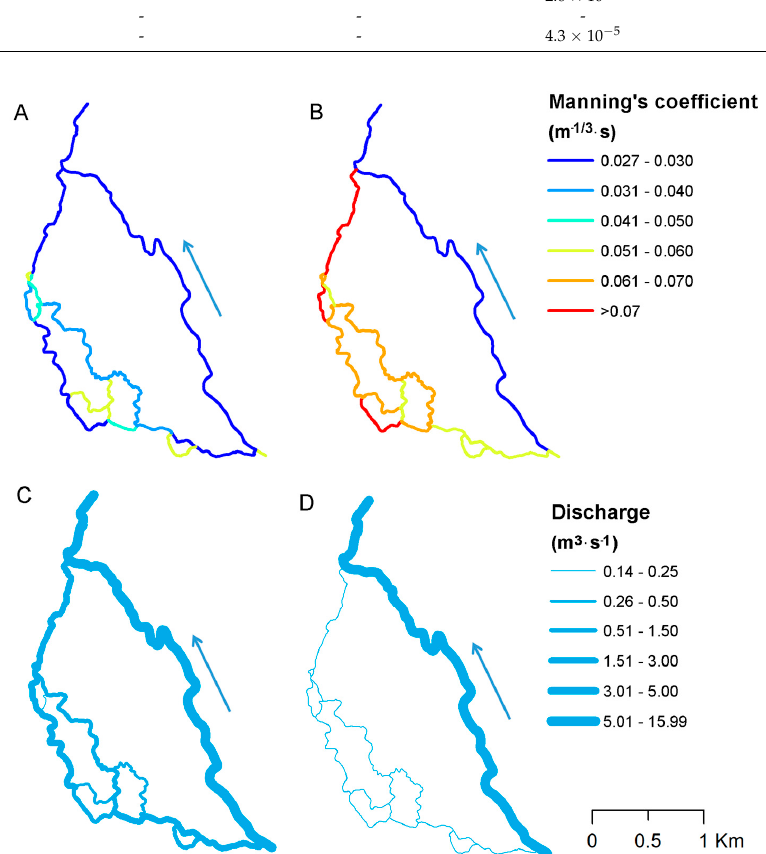
Figure 5. Spatial variability of Manning’s coefficients for: ( A ) the dormancy season; and ( B ) the growing season. Discharge distribution in: ( C ) the dormancy season; and ( D ) the growing season. Blue arrow indicates direction of flow.